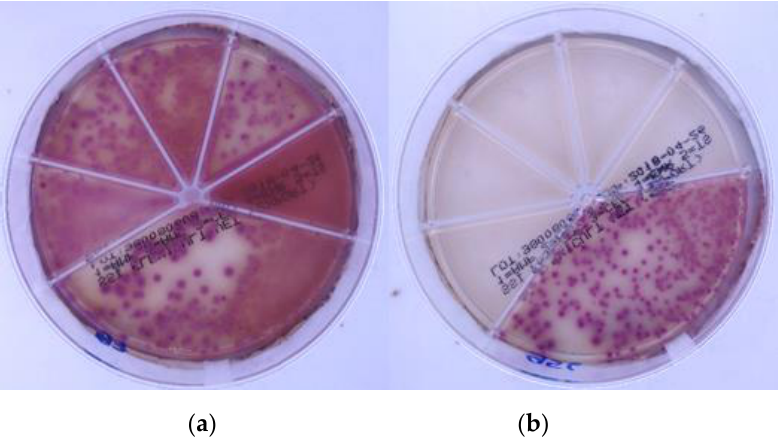
Figure 4. Escherichia coli on Flexicult Vet. The strains were falsely interpreted as ( a ) sensitive ( S ) or ( b ) resistant ( R ) to antibiotics. ( b ) resistant ( R ) to